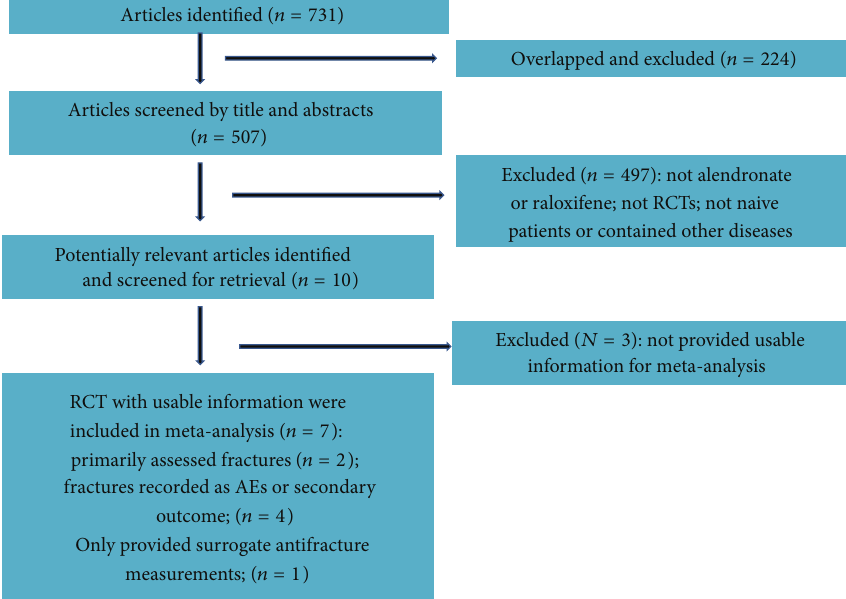
Figure 1: Flow chart for the